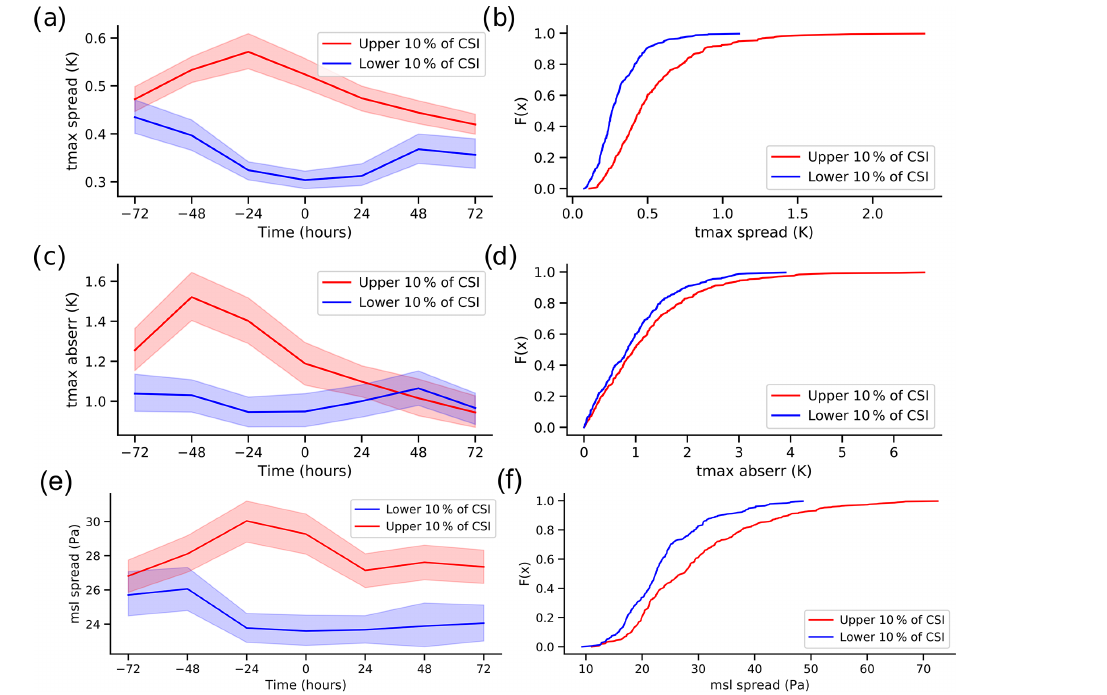
Figure 5. Forecast spread and skill for heat waves (upper 10% of CSI) and cool days (lower 10% of CSI). The lines show the mean temporal evolution of the ensemble model spread for T max (a) , SLP (e) and the absolute error for T max (c) of forecasts with a lead time of 69h, initialized at different time lags with respect to the events, calculated every 24h. The events are centered (0h) on the first day of CSI ≥ 90% or CSI ≤ lower 10% and at 12:00UTC. The CDFs of the mean ensemble forecast model spread for T max (b) , SLP (f) and the absolute error of T max (d) for the forecasts with a lead time of 69h initialized at 00:00UTC. A 95% bootstrap confidence interval is shown using shading for the temporal evolution plots (a, c, e) . The plots are displayed for the time of forecast initialization (see Sect.